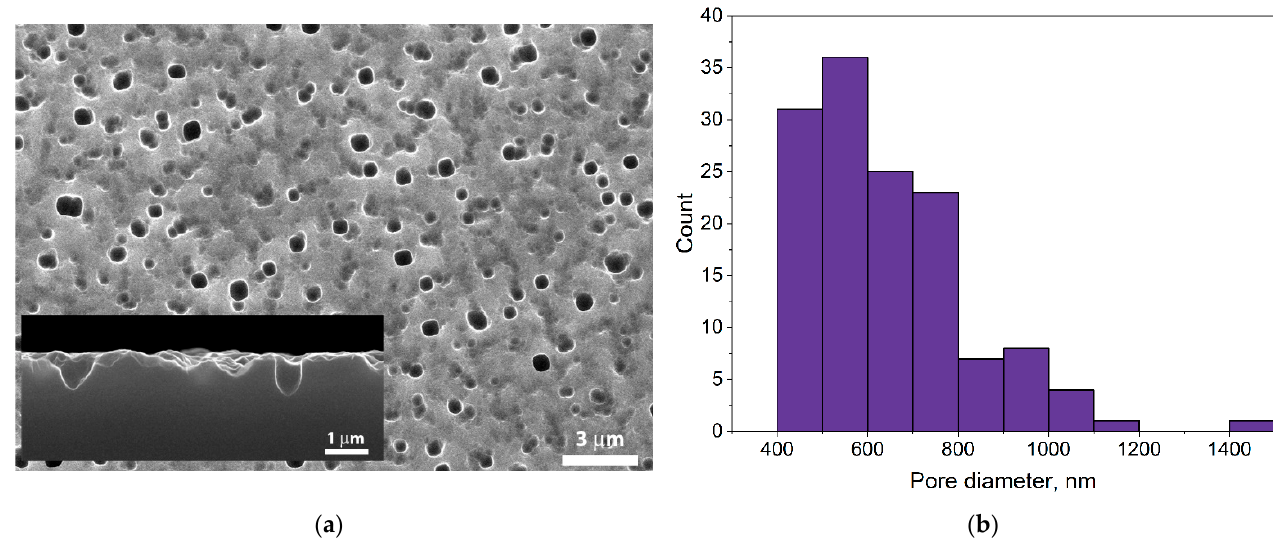
Figure 5. SEM images for a macro-PS sample ( a ) and the corresponding distribution of the pore opening diameters ( b ).